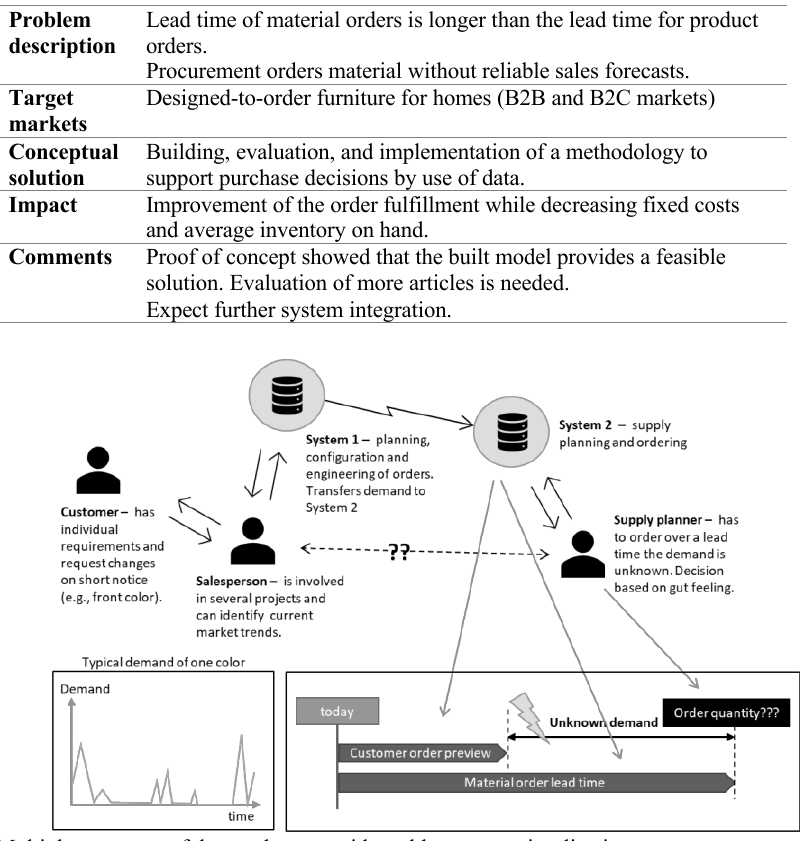
Fig. 2. Multiple resources of data and actors with problem space visualization